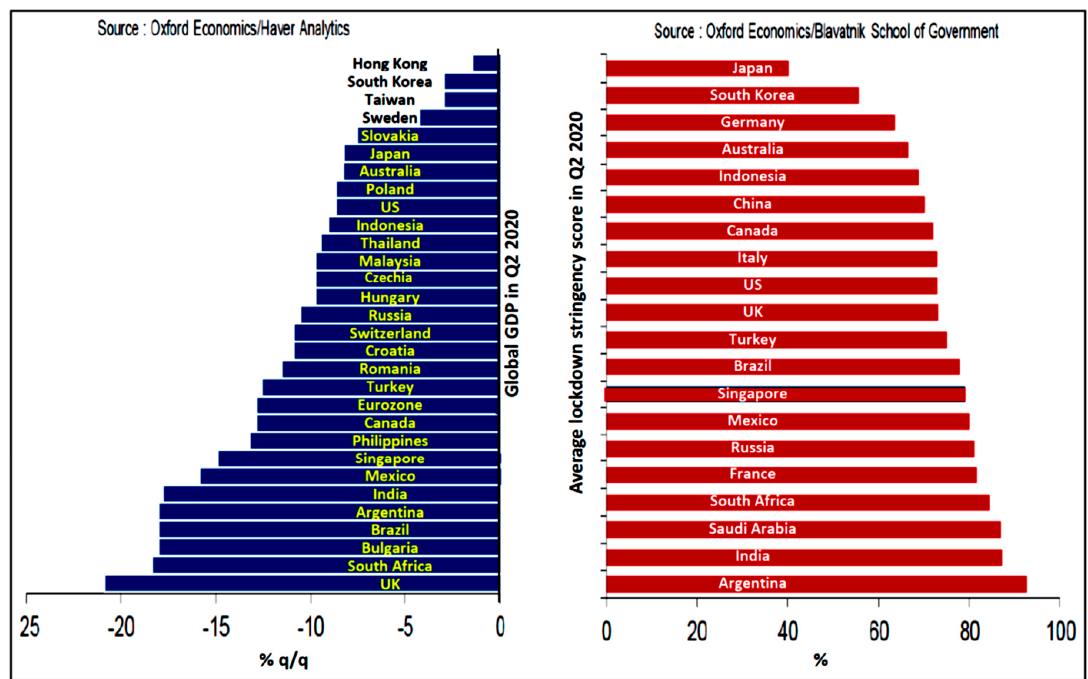
Figure 5. Fall in the gross domestic product (GDP) in the second quarter of 2020 in various countries and the lockdown stringency score.